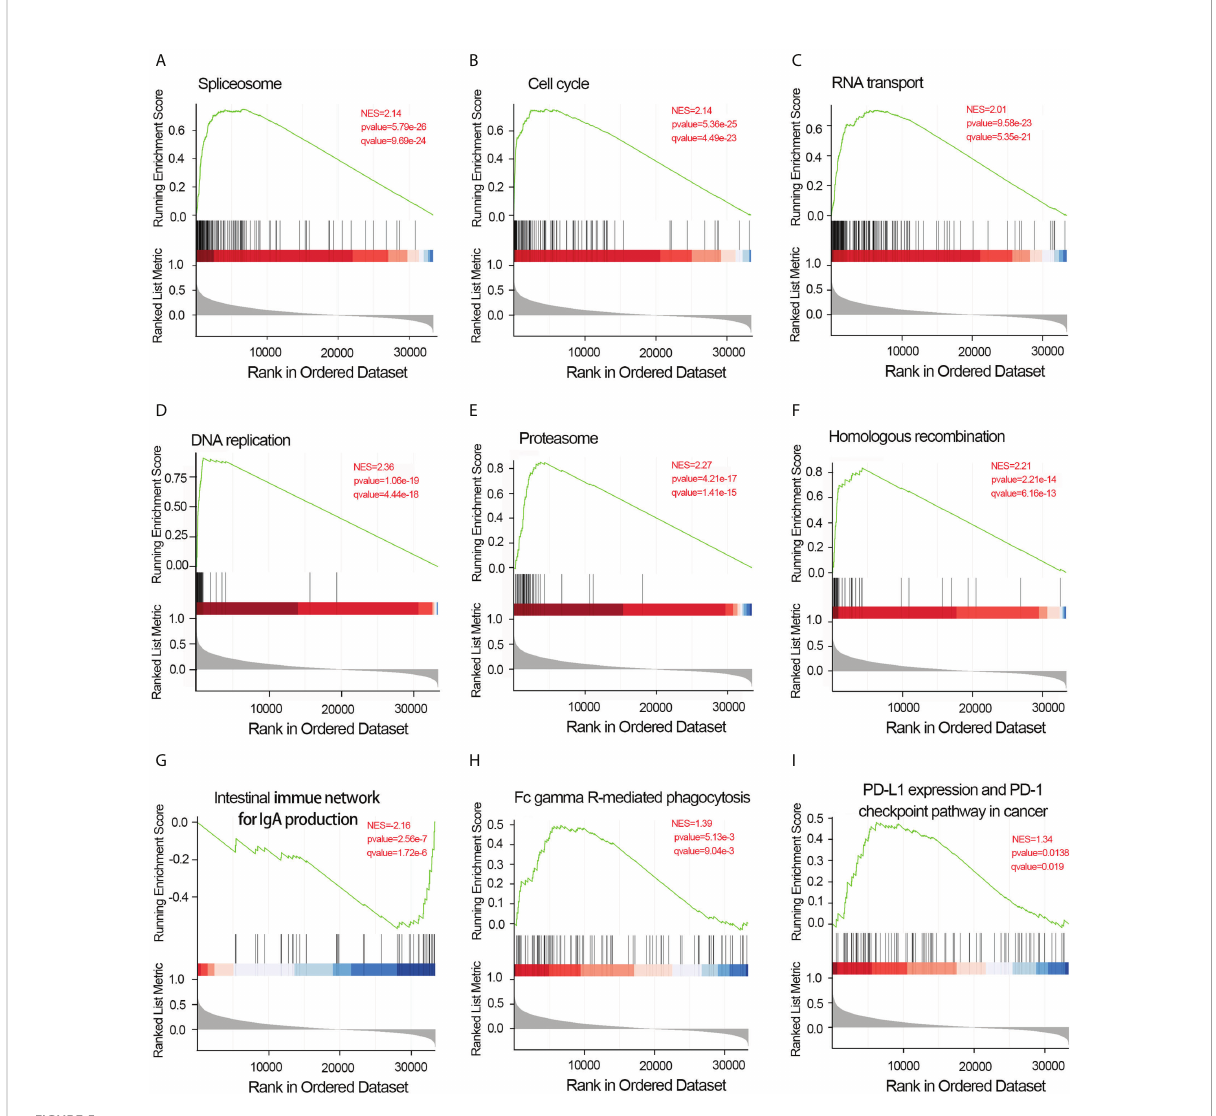
FIGURE 5 Results of gene set enrichment analysis of CDCA4. (A) Spliceosome. (B) Cell cycle. (C) RNA transport. (D) DNA replication. (E) Proteasome. (F) Homologous recombination. (G) Intestinal immune network for IgA generation. (H) Fc gamma R-mediated phagocytosis. (I) PD-L1 expression and PD-L1 checkpoint pathway in cancer. NES, normalized enrichment score; FDR, false discovery